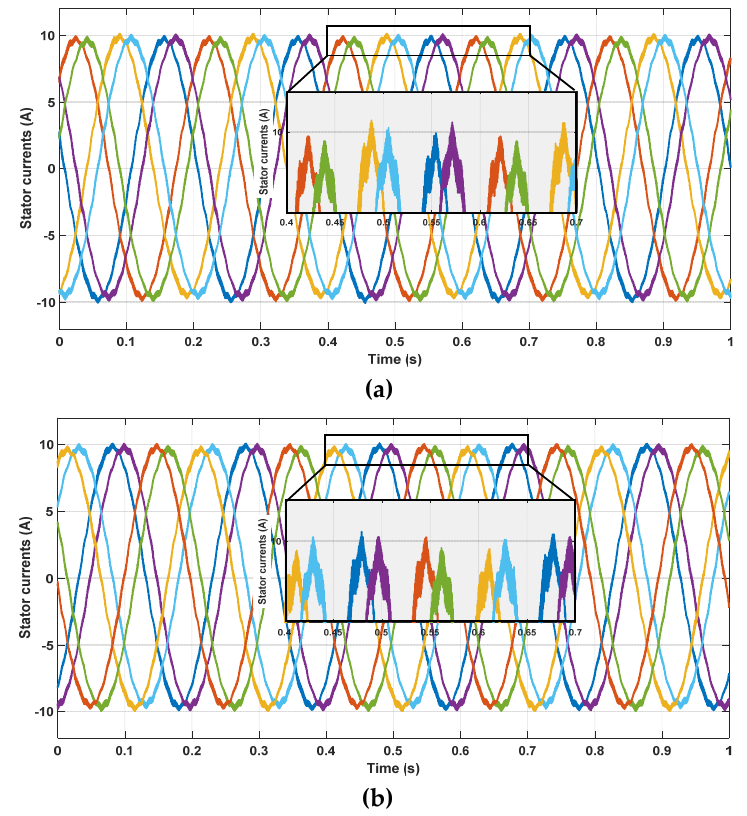
Figure 7. Experimental results: behavior of the drive using the proposed IFOC. Stator currents waveforms under ( a ) healthy and ( b ) HRC (R add = 0.7 pu).